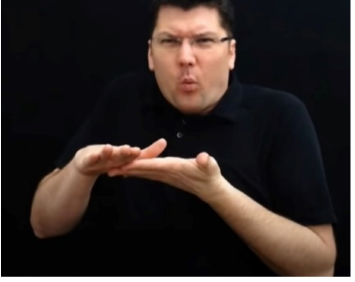
Figure 1. Pursed lips intensify the sign SMOOTH in ASL